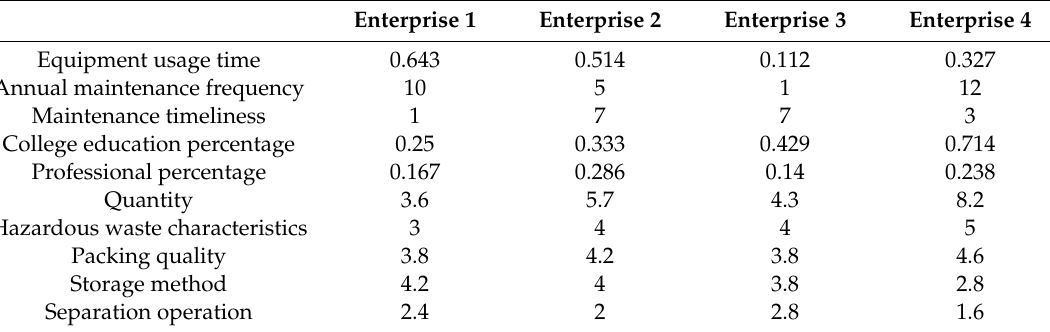
Table 6. Initial case companies’